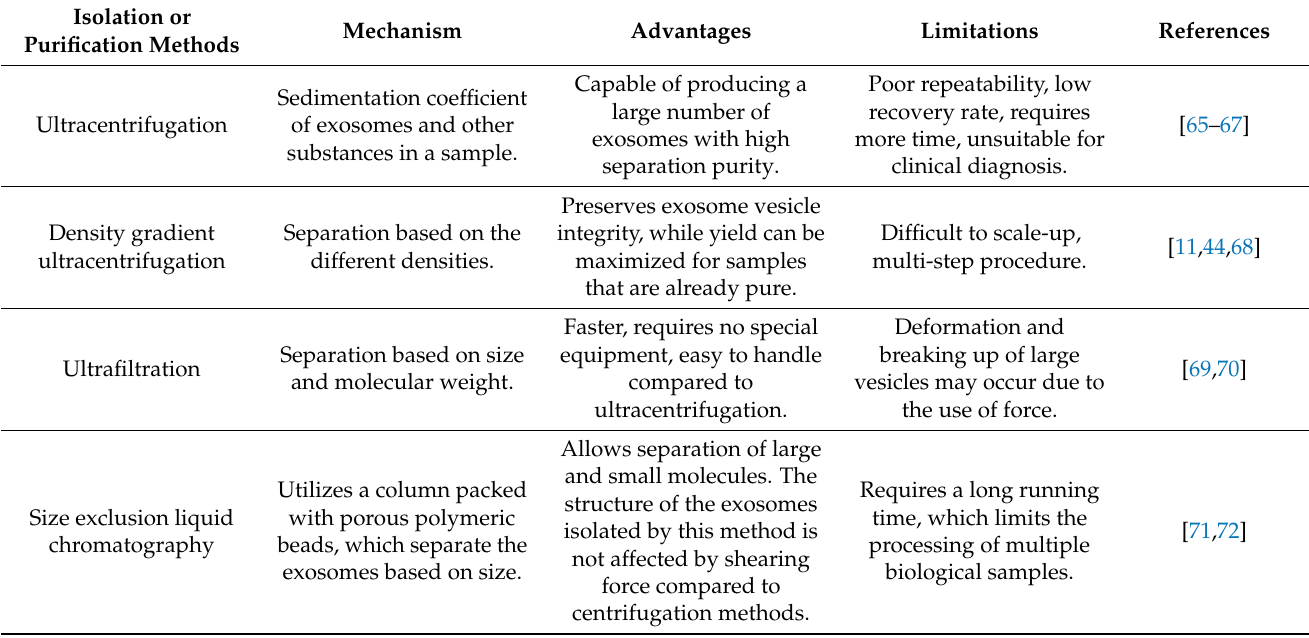
Table 1. Strategies, advantages, and disadvantages of exosome isolation or purification